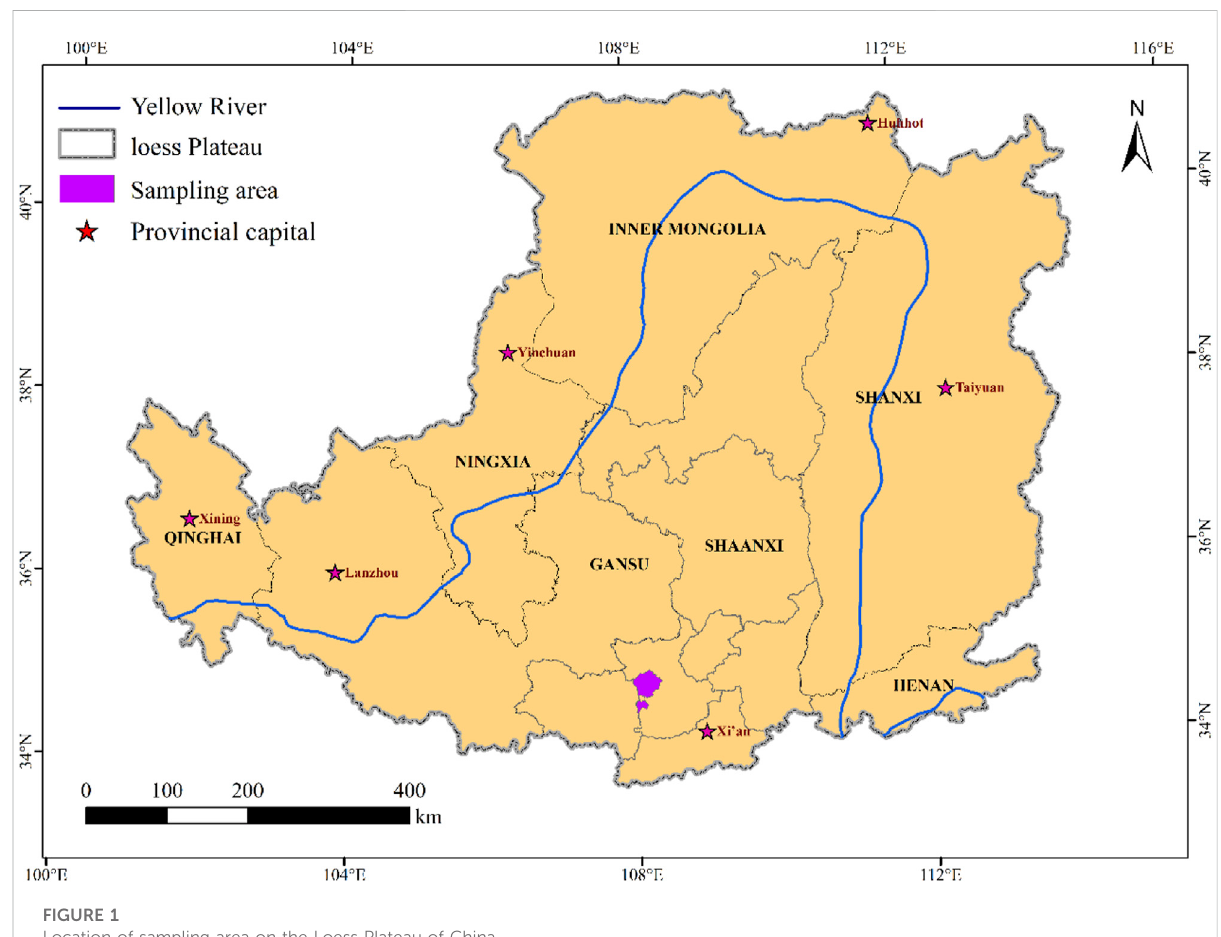
FIGURE 1 Location of sampling area on the Loess Plateau of